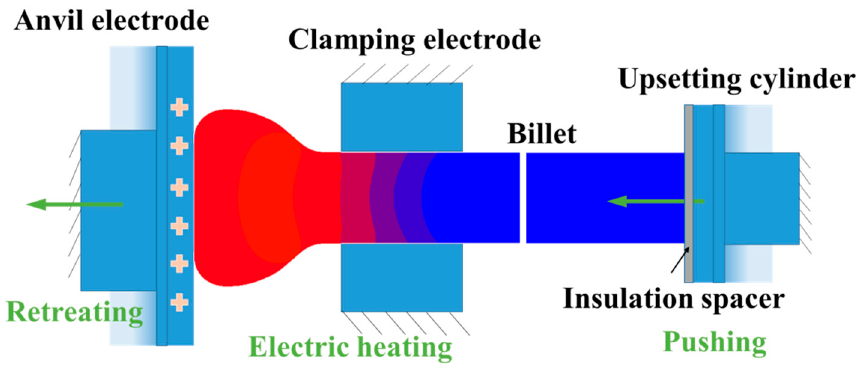
Figure 1. Schematic illustration of electric upsetting process.